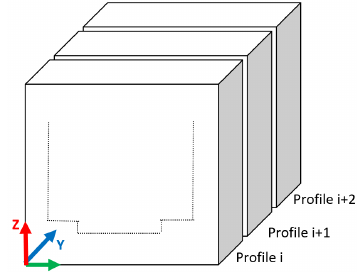
Figure 2: Reference system used for orienting the point cloud and consequently the cross